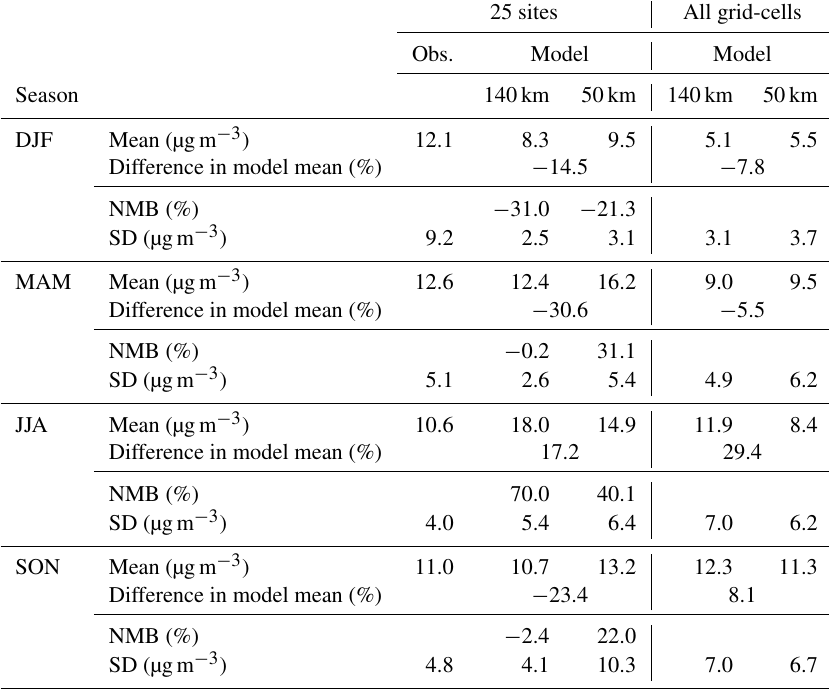
Table 2. Statistical results comparing seasonal mean PM 2 . 5 concentrations simulated at the coarse and finer resolutions to observations from 25 stations within the EMEP network in 2007. Statistical results for all model grid-cells of both resolutions are also shown. Percentage differences between the two model resolutions are calculated as (PM 2.5 coarse resolution − PM 2.5 finer resolution )/ (PM 2.5 coarse resolution )